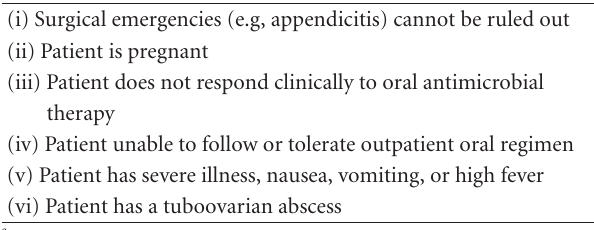
Table 5: Suggested criteria for hospitalization for treatment of acute PID a